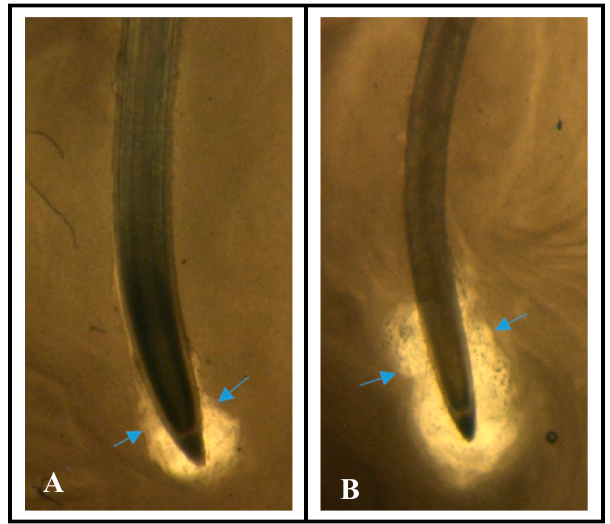
Figure 1. Increased mucilage production in “Solar”. The size of the mucilage layer (clear area denoted by blue arrows) from root tips of ( A ) conventional barley “Kopious” and ( B ) drought tolerant “Solar” is visualized using India ink, which cannot penetrate the mucilage surrounding border cells.